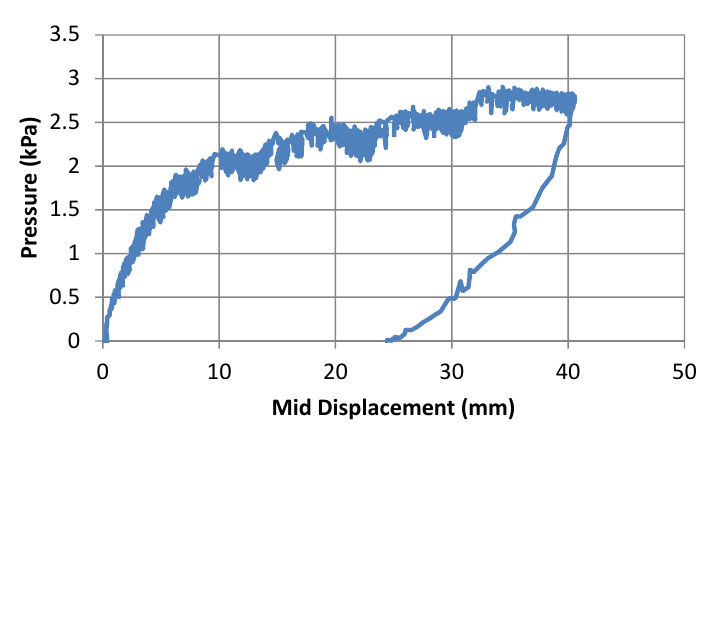
Figure 8. Pressure-displacement relationship at middle of wall for test